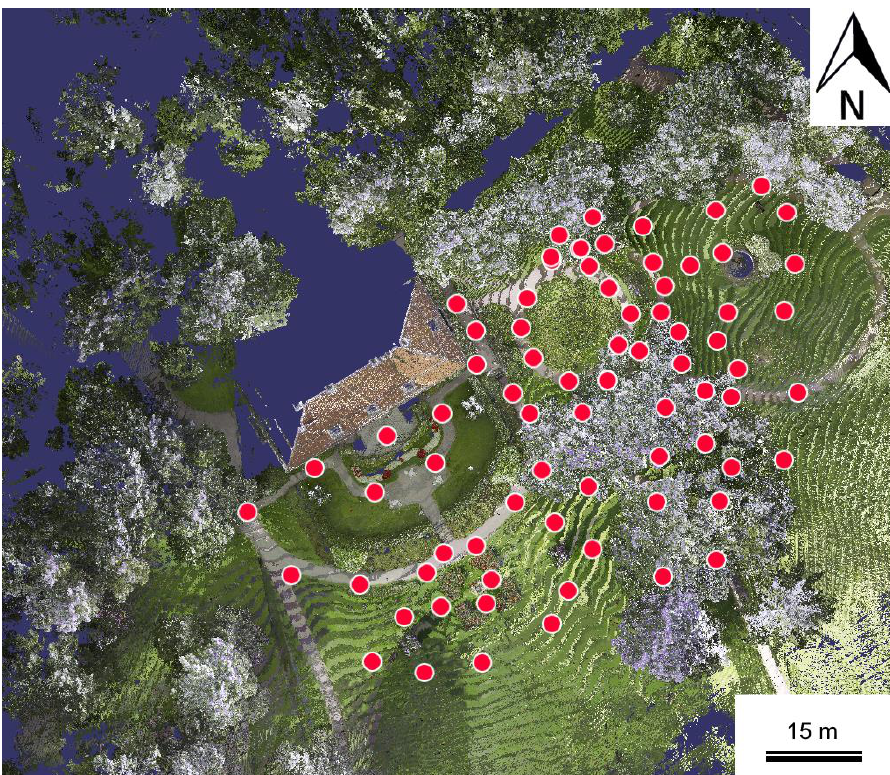
Figure 3. Leica RTC360 scanning positions.